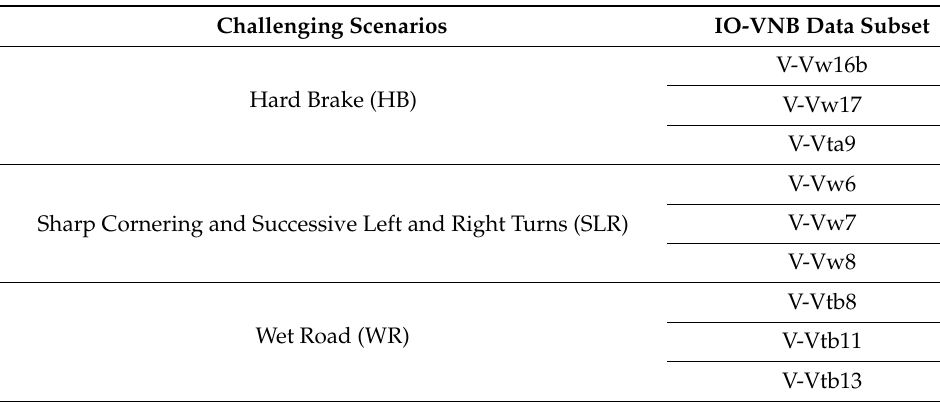
Table 1. Inertial Odometry Vehicle Navigation Benchmark Dataset (IO-VNB) datasets used in the performance evaluation on the localisation